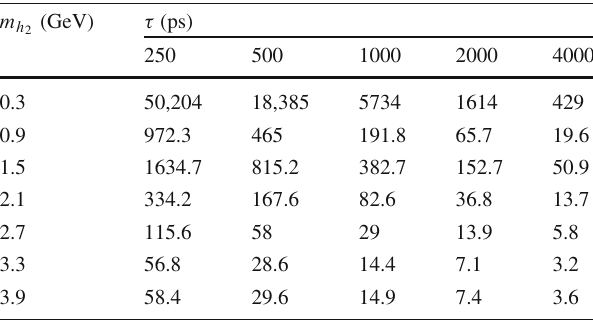
Table 1 Total number N tot of displaced-vertex B → K ( ∗ ) h 2 [→ f ] f events (see Eq. (B.23)) occurring in the CDC of Belle II for various values of the proper lifetime (columns) and mass (rows) of h 2 . All charges of the final state mesons K and K ∗ are included, as well